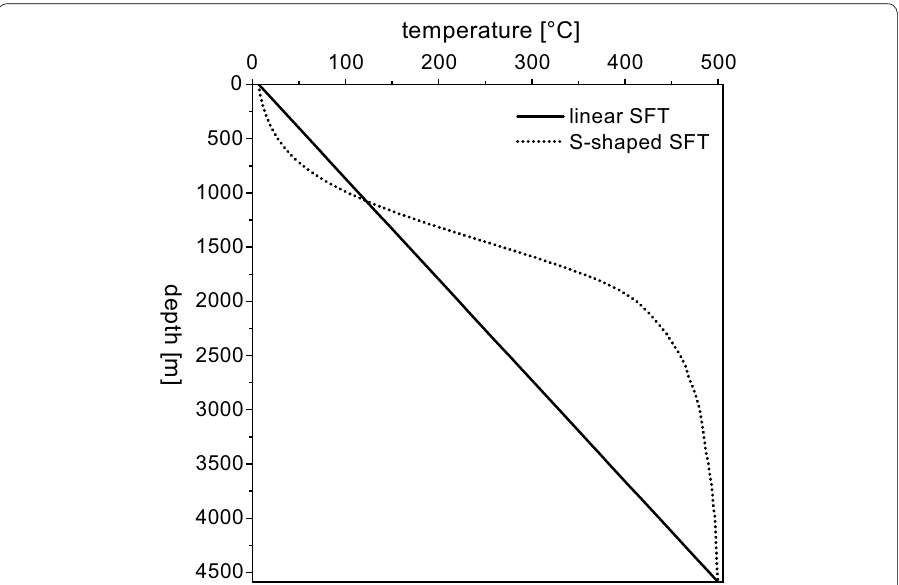
Fig. 2 Two different SFT profiles assumed in the high-temperature environment simulations: linear SFT describes a pure heat conduction geothermal system, S-shaped SFT reflects typically occurring convection zones in the geothermal system